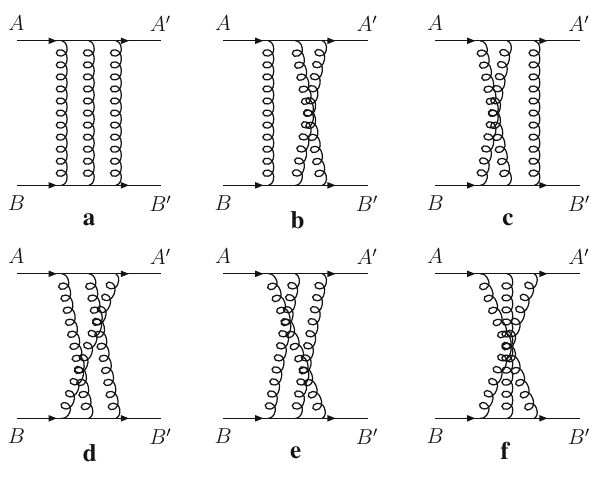
Fig. 1 Three-gluon exchange